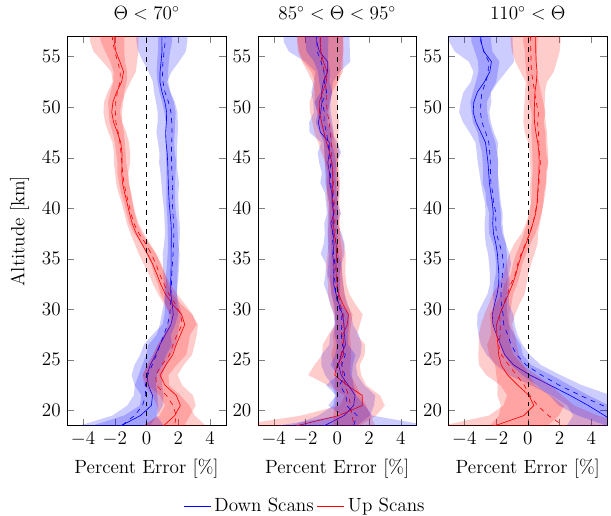
Figure 7. Mean percent difference between retrieved ozone number density when the forward model is run with one diffuse profile com- pared to five, i.e. ( [ O 3 ] ( 1 ) −[ O 3 ] ( 5 ) )/ [ O 3 ] ( 5 ) · 100%, as a function of altitude in select solar scattering angle bins. Shaded areas are the SD of the values. Solid and dashed lines represent simulated and OSIRIS measurements